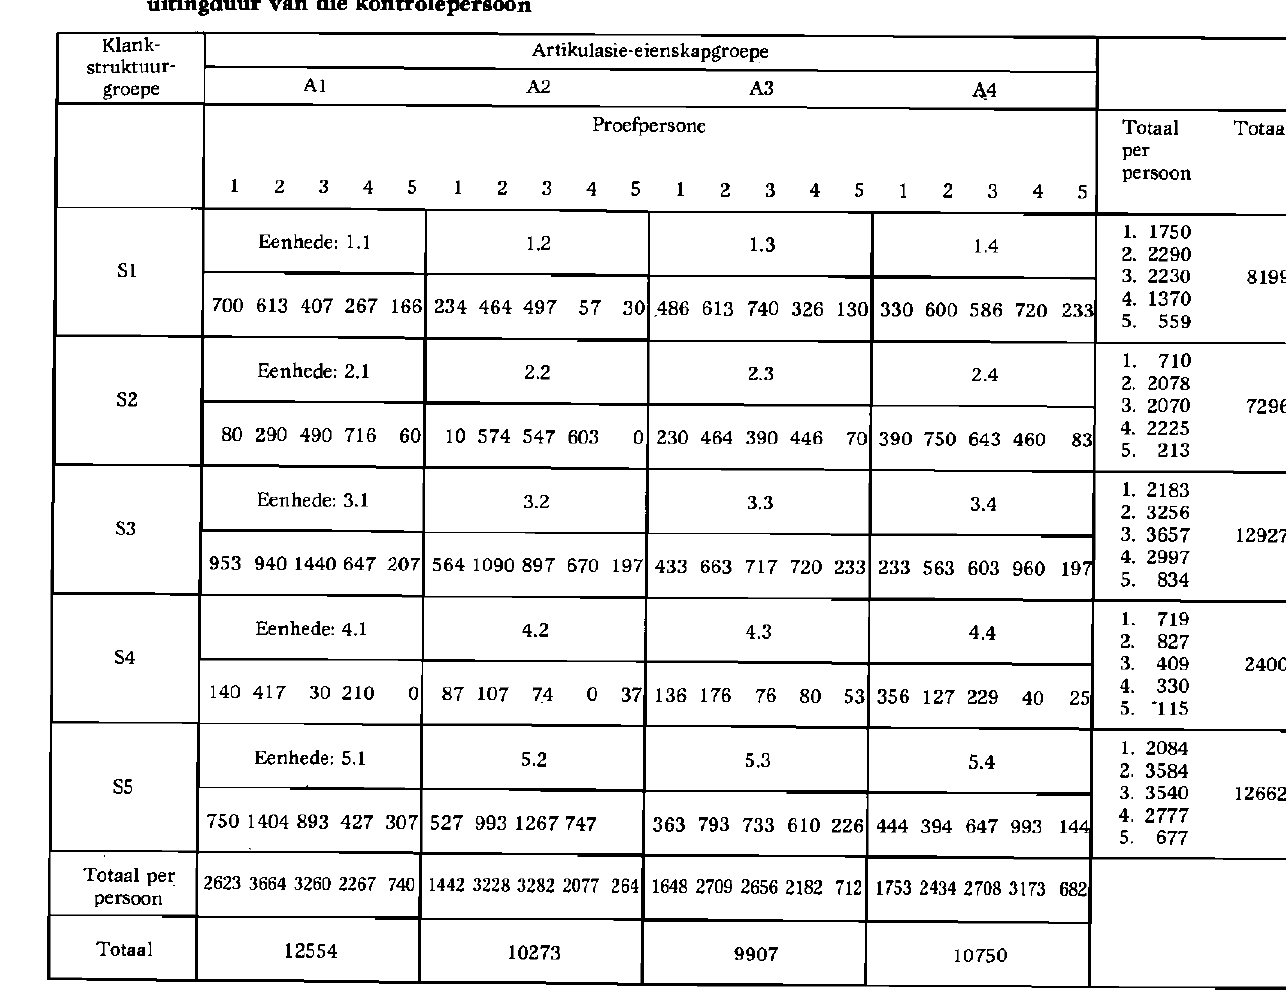
Tabel 5: Die verskil in millisekondes tussen die gemiddelde uitingduur van die proefpersoon en die gemiddelde uitingduur van die